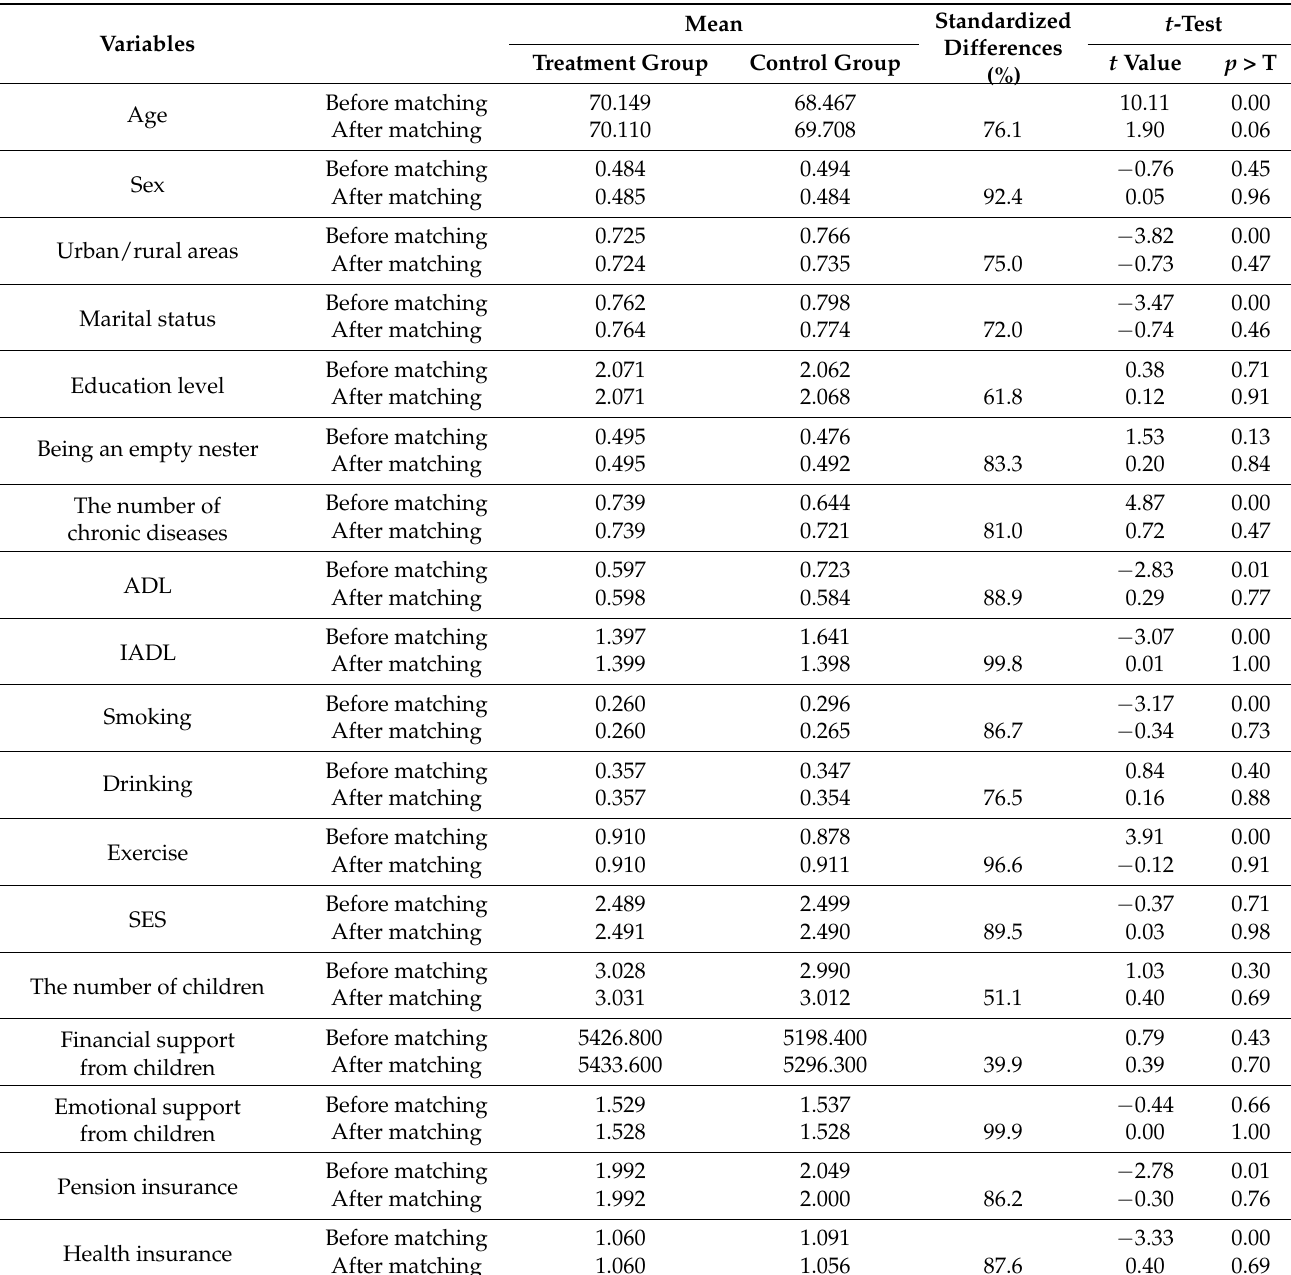
Table 3. Results of balance test (nuclear